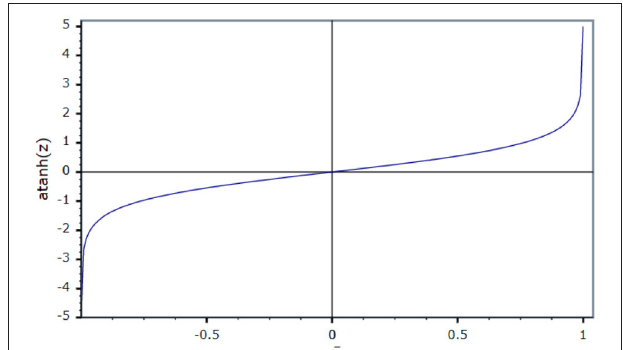
FIGURE 4 | Transfer function.